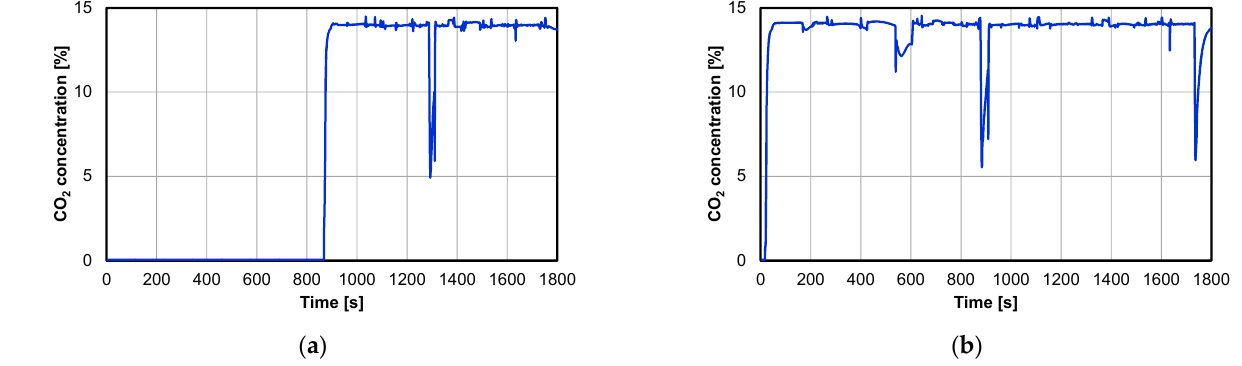
Figure 9. The CO 2 concentration versus time for: ( a ) plug-in; ( b ) HEV.